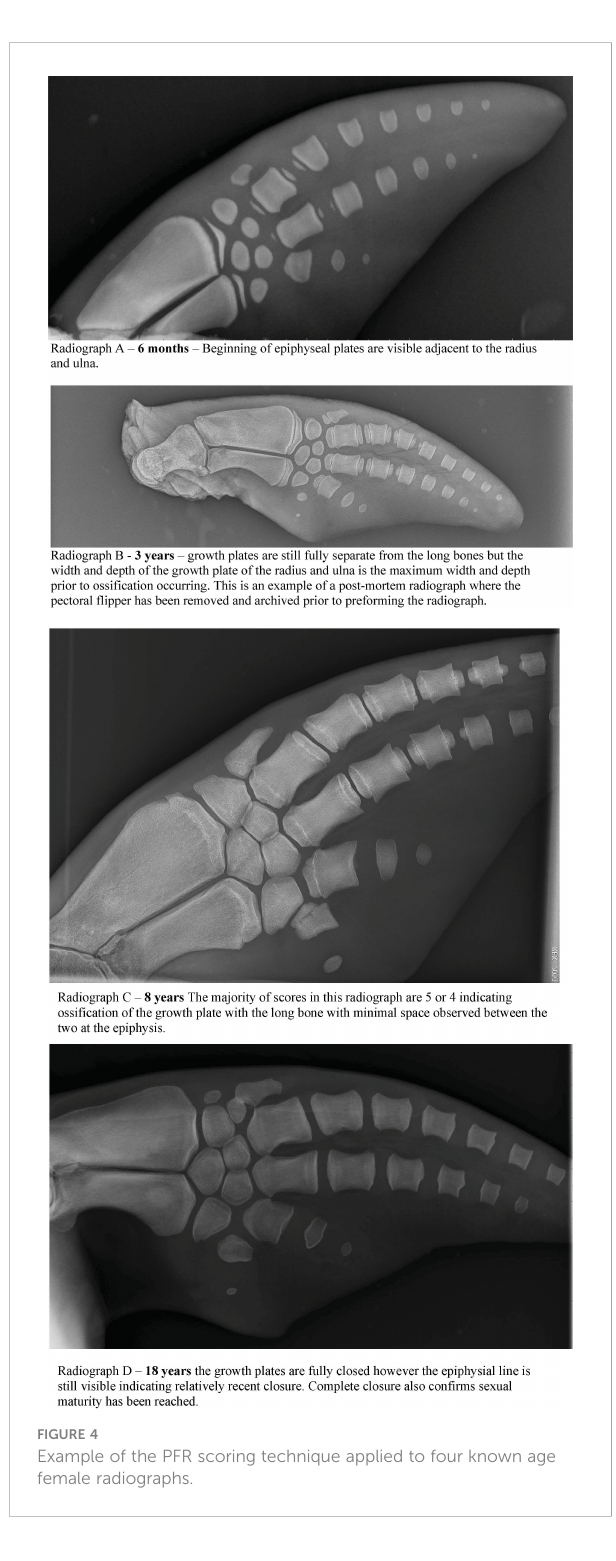
Sex-speci fi c equations are required due to the different growth rates between male and female bottlenose dolphins and the different